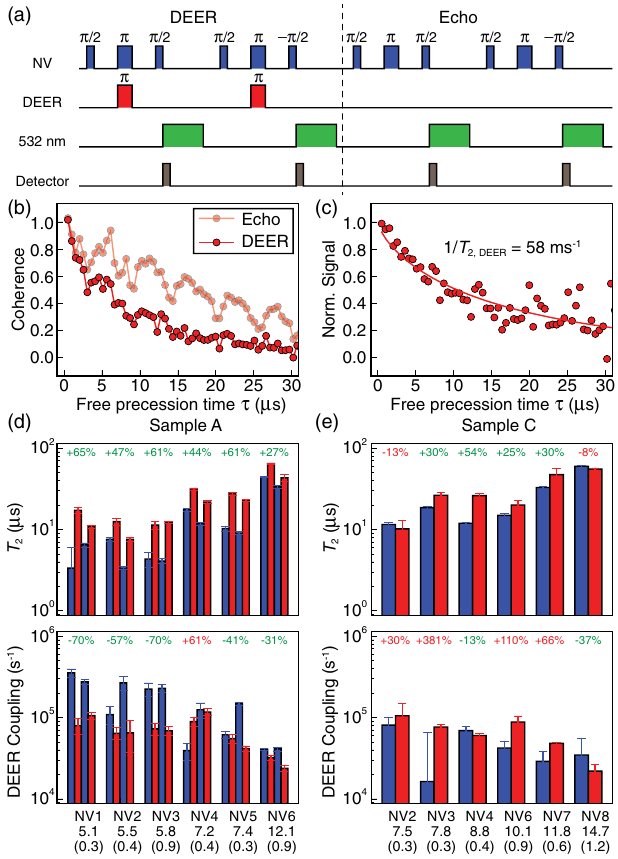
FIG. 12. (a) Pulse sequence for measuring DEER coupling: a DEER sequence is interleaved with a Hahn echo sequence to mitigate effects from slow system drift. The DEER driving = 2 π ≈ 920 MHz, corresponding to dark spins frequency is ω DEER with g ¼ 2 . (b) Hahn echo and DEER decay curves taken at ≈ 330 G. Collapse and revival arising from hyperfine cou- B z pling with a nearby 13 C can be observed. (c) Normalized signal, where the 13 C modulation is no longer pronounced. (d),(e) Spin echo coherence time and DEER coupling for several NV centers in sample A and sample C before and after oxygen annealing. Green (red) numbers indicate the average improvement (wors- ening) in the decoherence rate 1 =T 2 , and the average reduction (increase) in the DEER coupling after oxygen